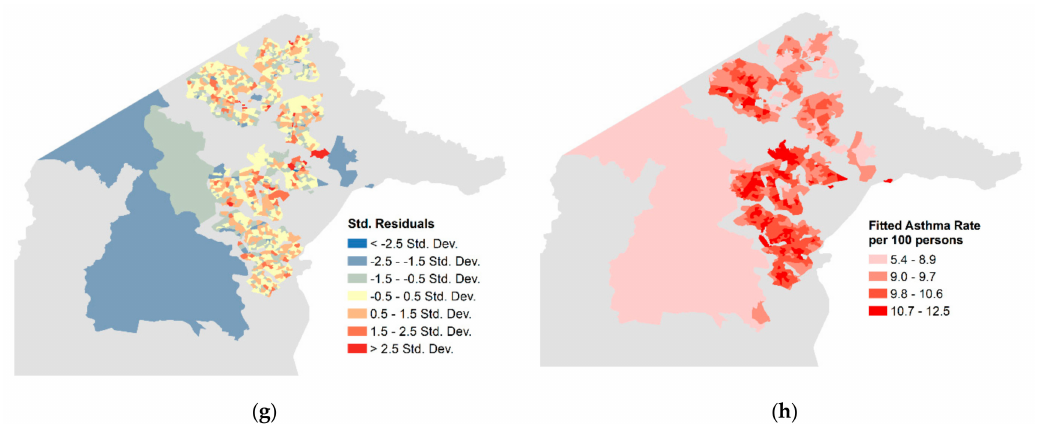
Figure 1. Maps of asthma rate and Geographically Weighted Poisson Regression (GWR) results for residential areas in the ACT: ( a ) Asthma rate; ( b ) ED coe ffi cients; ( c ) Over65 coe ffi